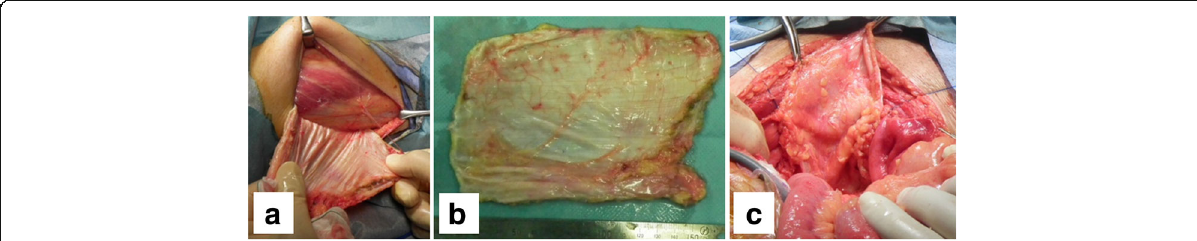
Fig. 2 Surgical repair of the pelvic floor defect with a fascia lata free flap. A 15-cm incision was made, and a fascia lata flap (15×9 cm) was created from the left thigh ( a , b ). The patch was fixed to the edge of peritoneum and the ileal conduit wall ( c )